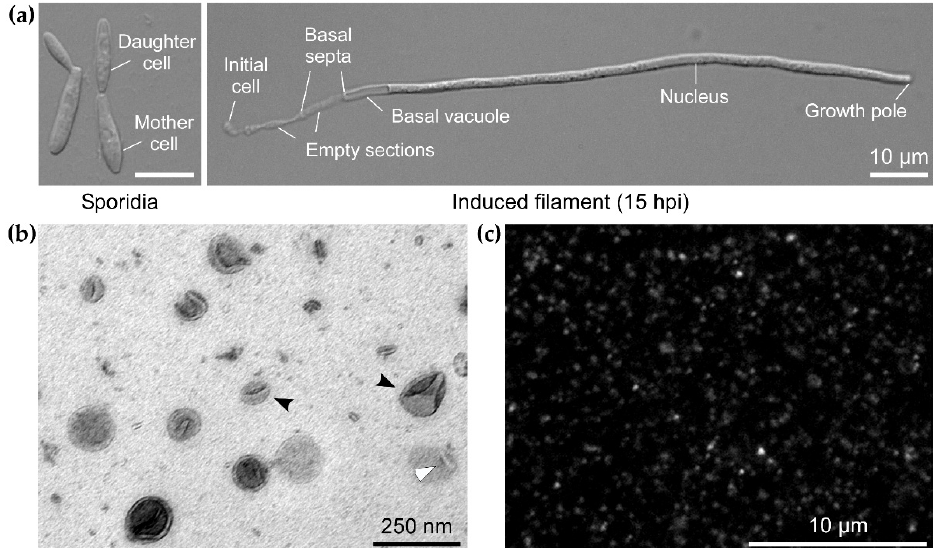
Figure 1. Extracellular vesicles (EVs) from axenic filamentous culture of Ustilago maydis . ( a ) Infectious filamentous development was induced in axenic culture using the laboratory strain AB33 [34]. In this strain, the transcriptional cascade of genes necessary for infection and dimorphic switch from yeast-like budding sporidia (left) to hyphal filament (right), can be induced by switching the nitrogen source (both scale bars = 10 µm). EVs were prepared from cultures of filaments between 15–16 h post induction as the one shown on the right. ( b ) Transmission electron micrograph of EVs from filamentous culture of AB33 (scale bar = 250 nm). Typical cup-shaped morphology of EVs is due to fixation. Examples of a smaller and a larger EV are indicated with black arrowheads and an EV lysed during sample preparation is marked with an empty arrowhead. ( c ) Staining of AB33 filament EVs with the lipophilic dye FM4-64 (scale bar = 10 µm). Larger brighter spots are most likely aggregates of EVs formed due to ultracentrifugation.